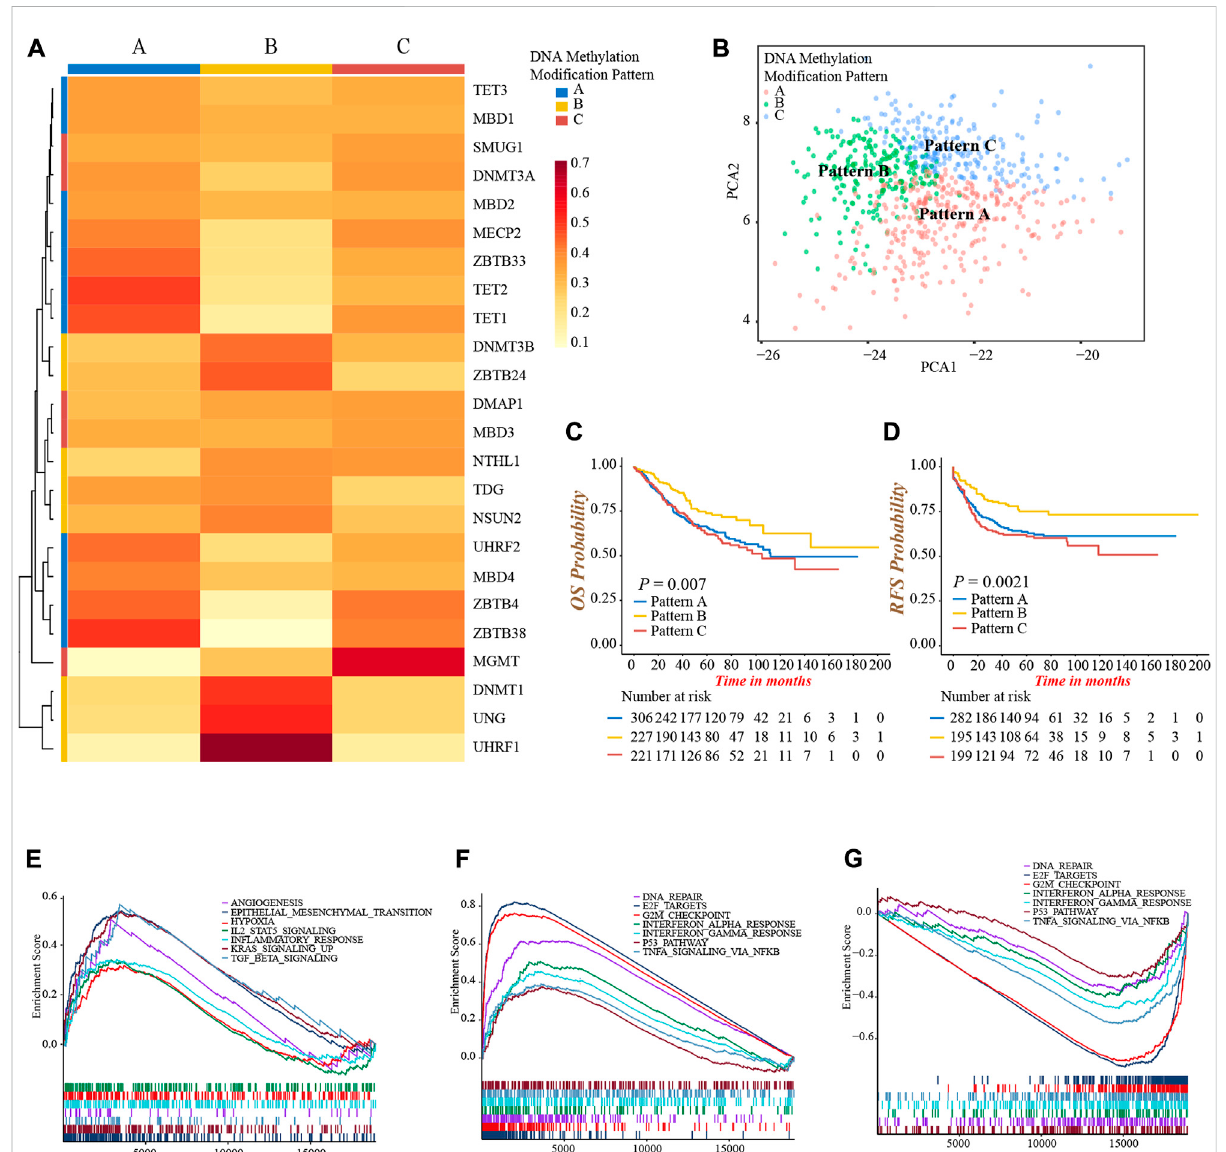
Identi fi cation of DNA methylation modi fi cation patterns and prognostic and pathway analyses. (A) Unsupervised clustering of 24 DNA methylation regulators in meta-cohort. (B) PCA graph for the transcriptomic pro fi les of three DNA methylation modi fi cation patterns. (C) Overall survival analysis for the three DNA methylation modi fi cation patterns (Log-rank test, p = 0.007). (D) Recurrence-free survival analysis for the three DNA methylation modi fi cation patterns (Log-rank test, p = 0.0021). (E – G) GSEA enrichment analyses presented the activation status of biological pathways among distinct DNA methylation modi fi cation patterns. (E) Pattern-A; (F) Pattern-B; (G)